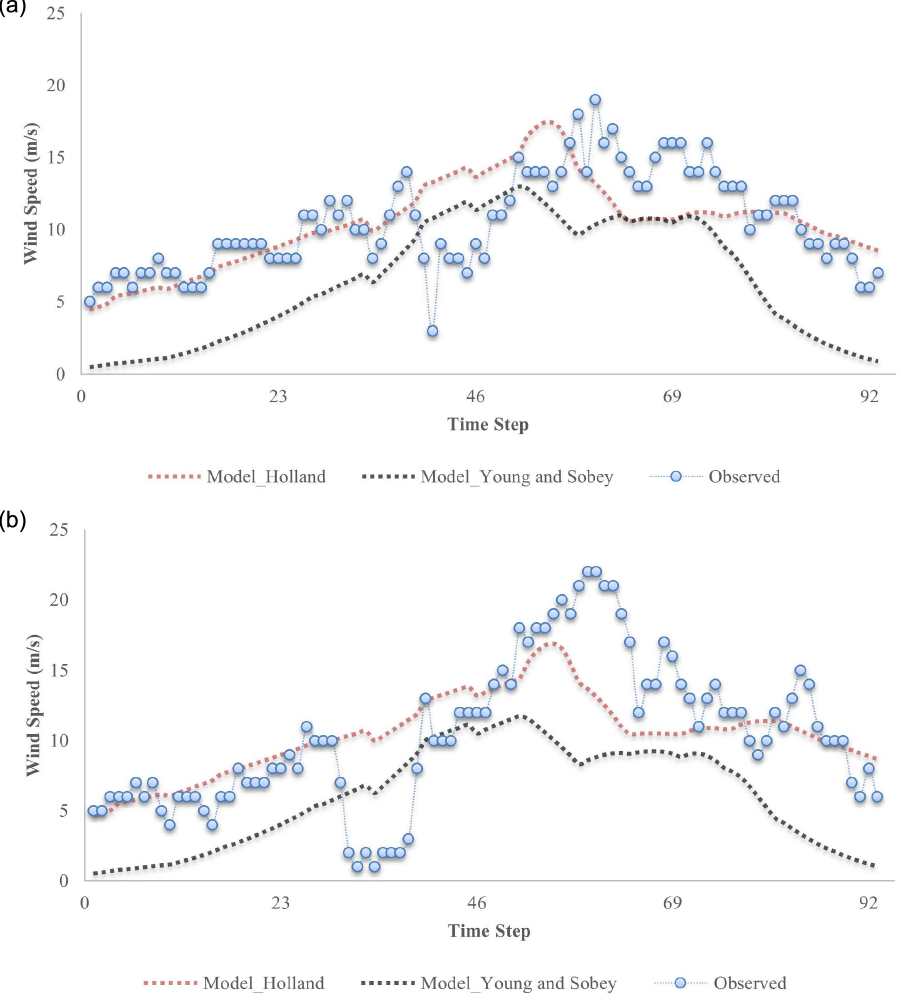
Figure 1. Model data comparison for (a) results at Tanxu station and (b) results at Daji station. The blue points indicate the observation data, the red curve shows the simulated results following the Holland model, and the grey curve represents the results computed by the Young and Sobey